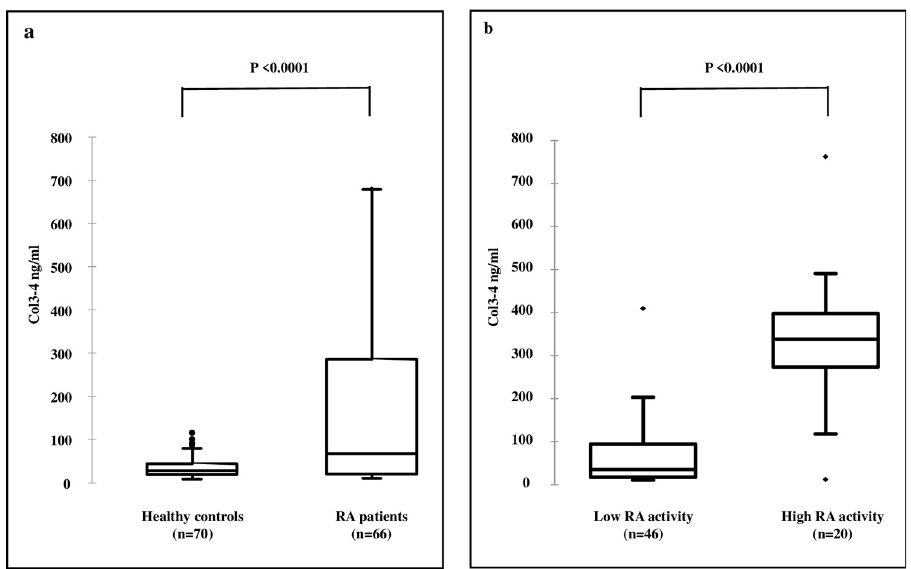
Fig 5. Box plots of serum Col3-4 levels in healthy controls and RA patients. a) Healthy controls vs RA patients; b) Patients with low-active vs high-active RA disease (DAS28-ESR cut-off � 3.2). The upper and lower limits of the box represent the 75 and 25 percentiles of the distribution respectively. The horizontal bar in the box is the median values of each group.